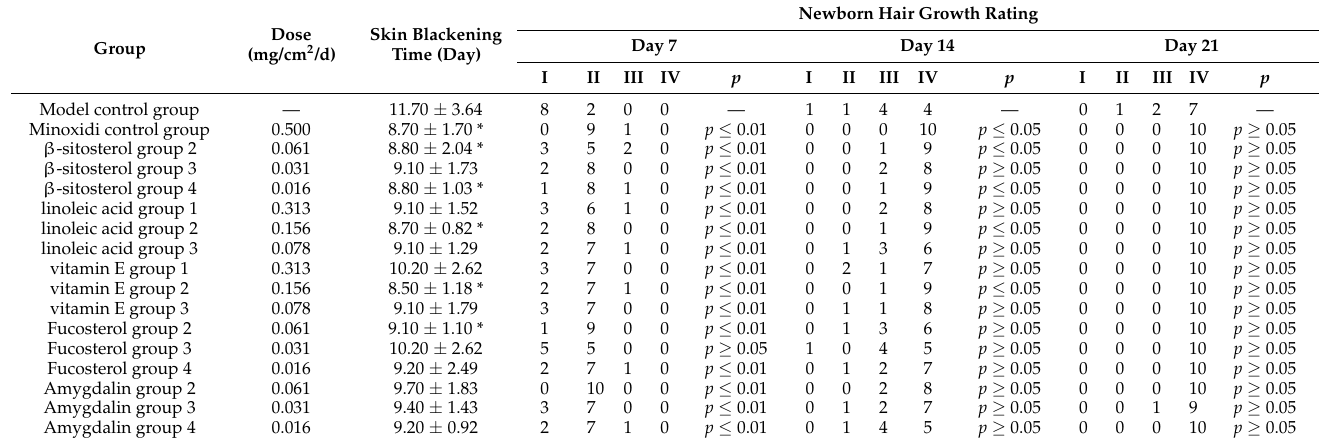
Table 14. Effects of five effective components in the kernel of P. mira on the newborn hair growth rating of C57BL/6 mice depilation model induced by sodium